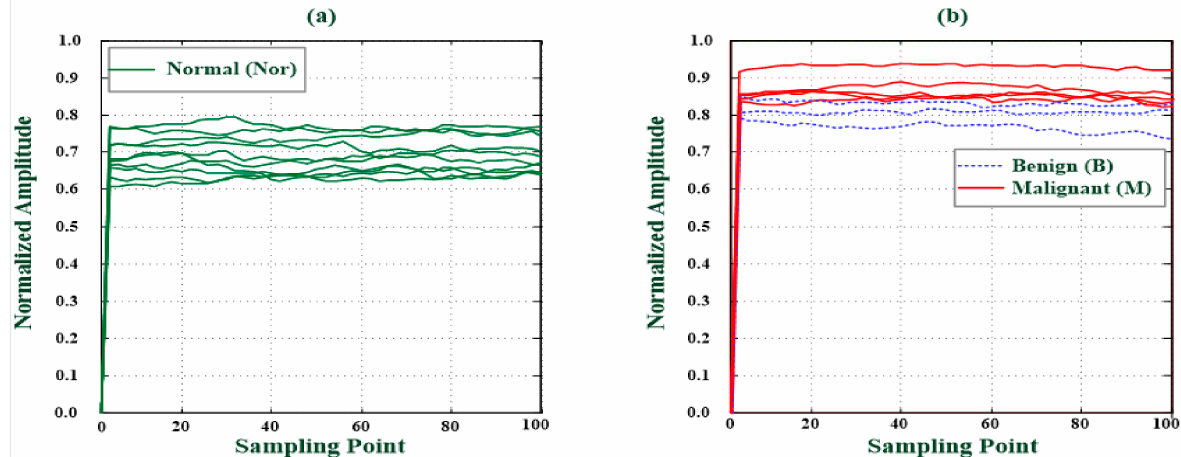
Figure 6. Downsampling 1D feature signals for normality (Nor) and abnormality levels (benign (B) and malignant (M)) as preliminary class identification. ( a ) Feature signals for normality level; ( b ) feature signals for abnormality